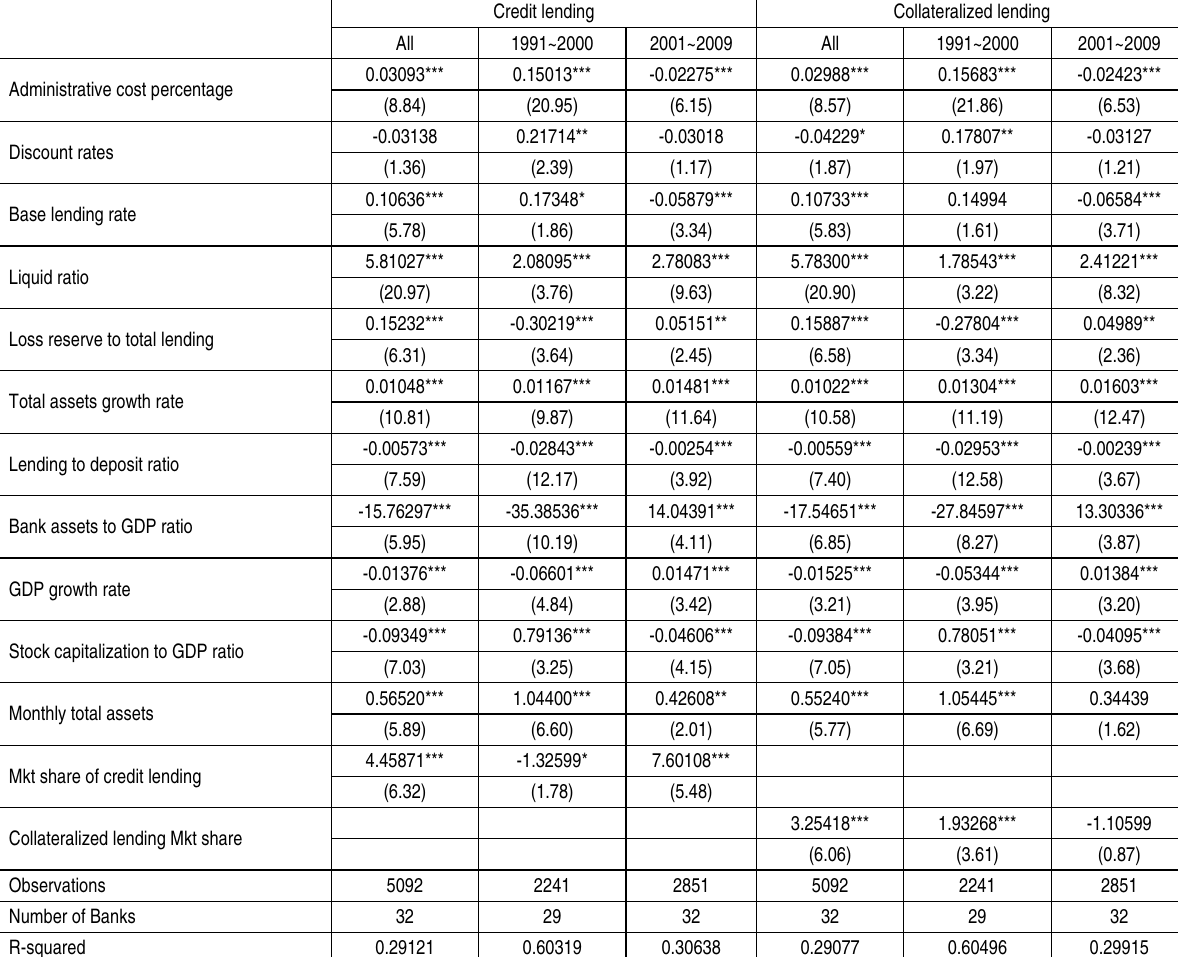
Table 6 (cont.). Credit lending and collateralized lending market shares – adding macroeconomic